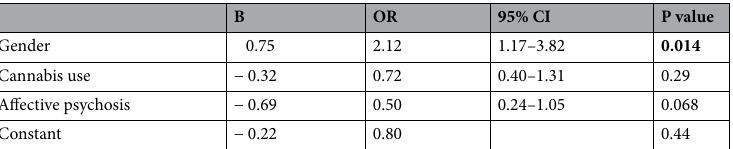
Table 3. Logistic regression analysis to determine the factors associated with FEP onset in the COVID-19 pandemic period vs. the corresponding period in the prior year. Significant values are in [bold]. B coefficient, OR odds ratio, CI confidence